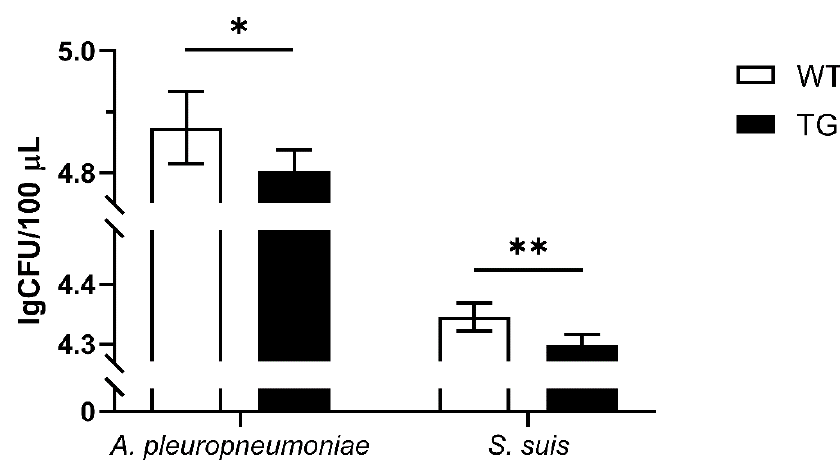
Figure 5. Bactericidal activity of cell culture supernatant. The cell culture supernatant of PEFs from TG pigs was incubated with A. pleuropneumoniae and S. suis for 1 h and the surviving bacteria were then plated on agar for counting. Cell culture supernatant of PEFs from WT pigs was used as a negative control. Data are presented as mean ± SD and are plotted from three independent experiments. * p < 0.05, ** p < 0.01, unpaired one tailed Student ′ s t -test.